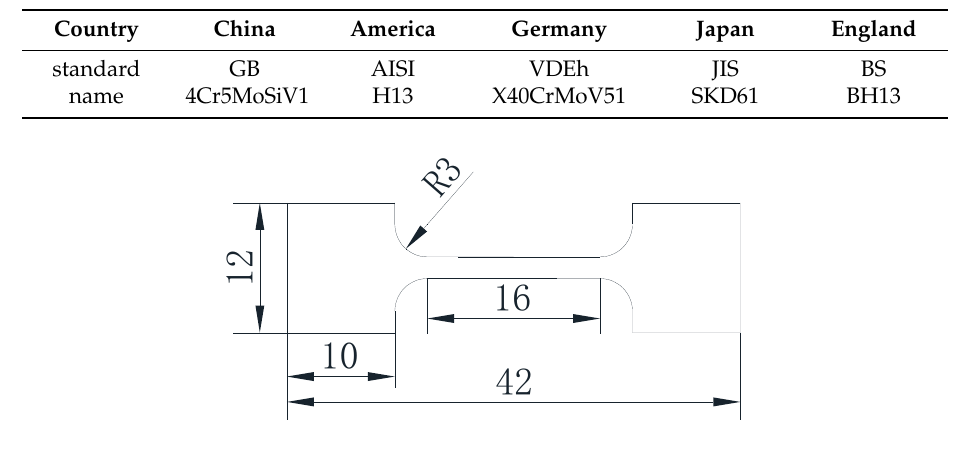
Table 1. The names and standards of the tensile test materials in different countries.